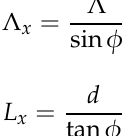
Figure 5. Geometry of the interference fringes.